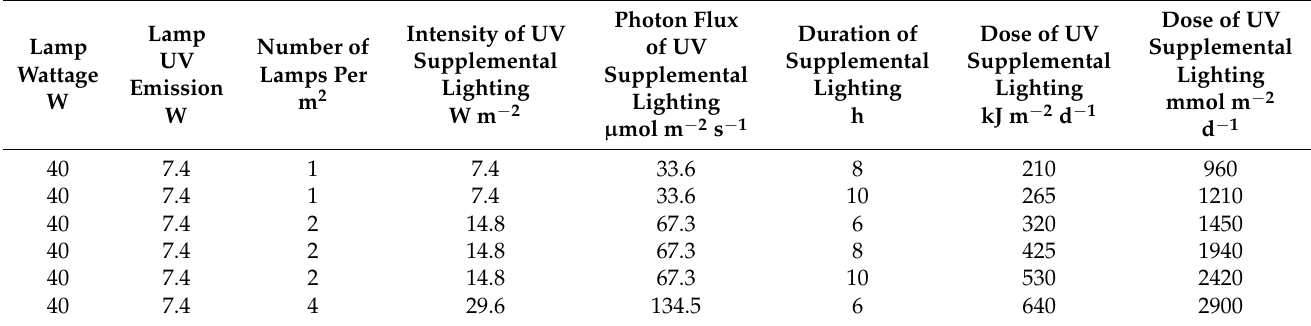
Table 1. Calculation of the dose of UV supplemental lighting in kJ m − 2 d − 1 and mol m − 2 d − 1 from lamps’ UV emission, number of lamps per m 2 , and the duration of the lighting in each treatment.